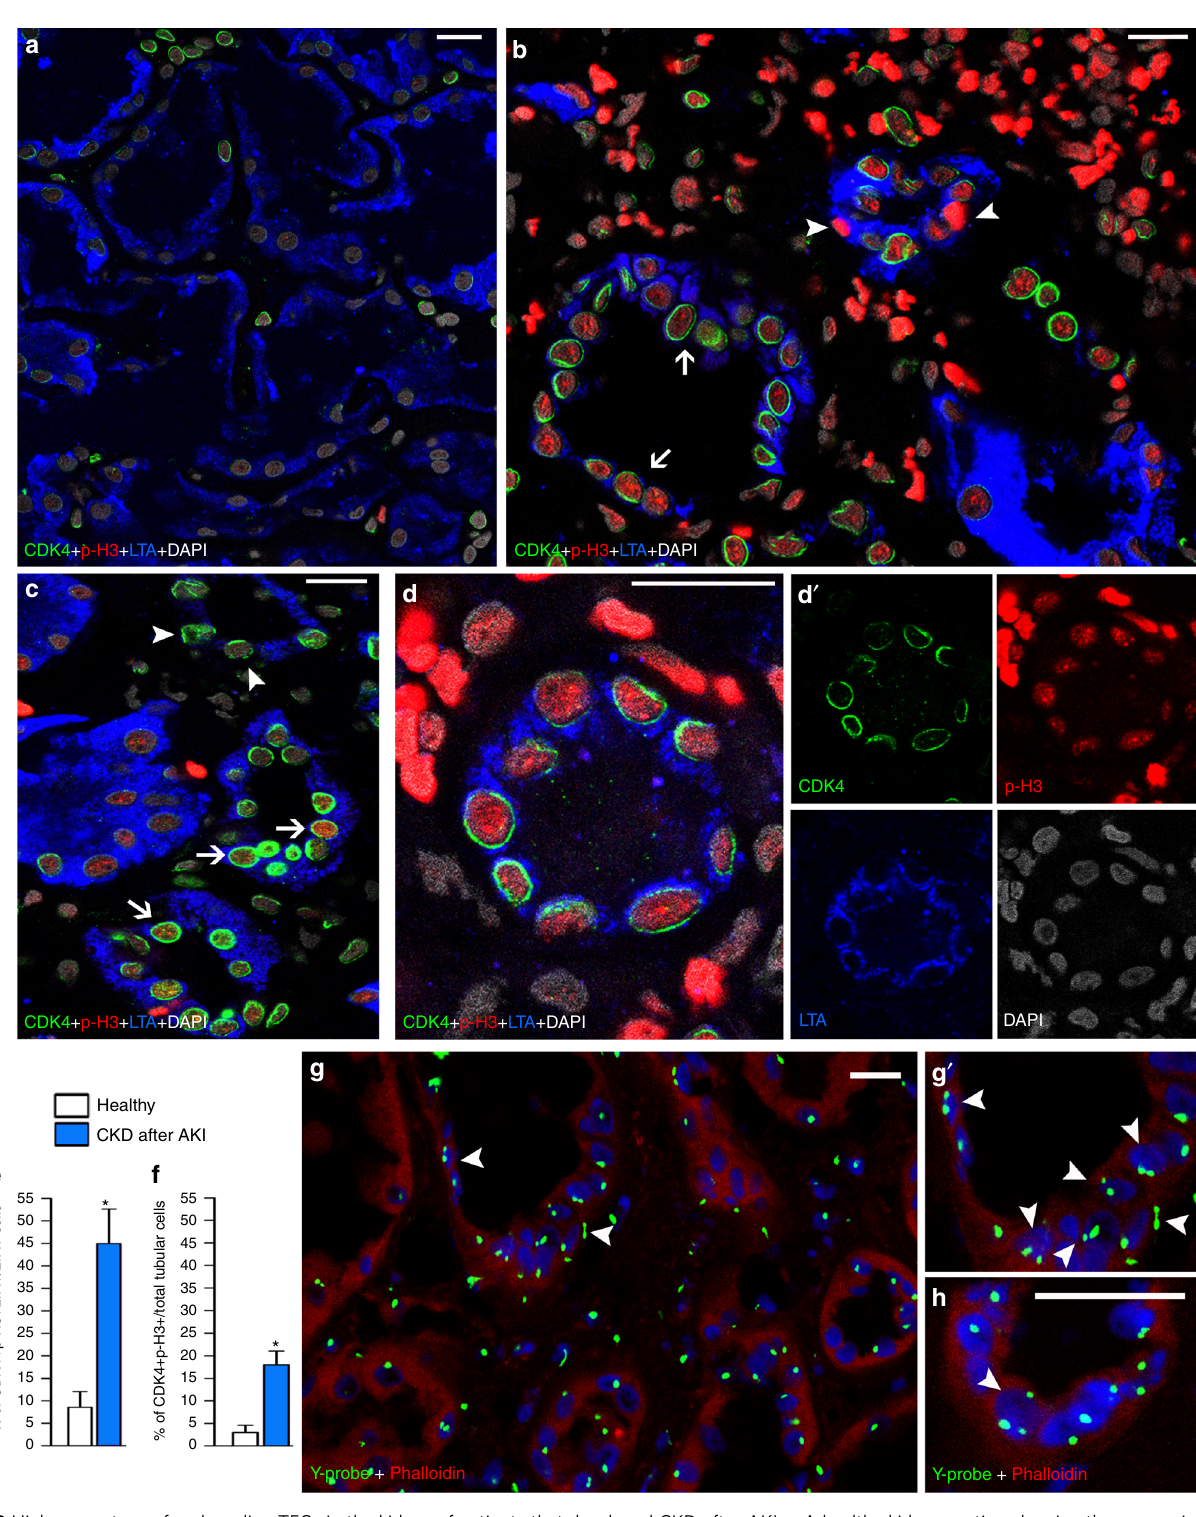
Fig. 8 High percentage of endocycling TECs in the kidney of patients that developed CKD after AKI. a A healthy kidney section showing the expression of CDK4 (green) and p-H3 (red) in LTA + proximal tubular cells (blue) ( n = 4). b – d A renal biopsy section from a patient that developed CKD after AKI ( n = 7) showing CDK4 + p-H3 + (green and red cells, arrows) and CDK4 − p-H3 + (red cells, arrowheads) or CDK4 + p-H3 − (green cells, arrowheads) in proximal tubular LTA + cells (blue). d ′ Split images of the tubule shown in d . e Percentage of CDK4 + p-H3 + LTA + cells over total proximal TECs (LTA + ) in healthy kidneys ( n = 4) and in renal biopsies from patients that developed CKD after AKI ( n = 7). Mann – Whitney test * p < 0.05. f Percentage of CDK4 + p- H3 + cells over total TECs in healthy kidneys ( n = 4) and in renal biopsies from patients that developed CKD after AKI ( n = 7). Mann – Whitney test * p < 0.05. g , g ′ A renal biopsy section from a patient that developed CKD after AKI ( n = 8) showing the presence of two or three Y chromosome-probe (green) in TECs labeled with Phalloidin (red), at different magni fi cations. Arrowheads indicate doubled dots for Y chromosome in a nucleus. h High magni fi cation of another biopsy fi eld. Arrowhead indicates triple dots for Y chromosome in a nucleus. DAPI counterstains nuclei. Data are mean ± SEM. Scale bars 20 µ